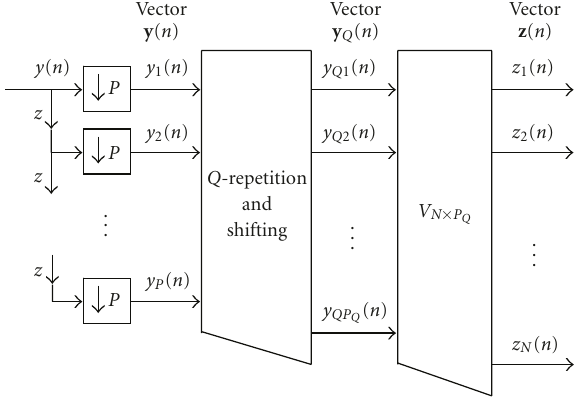
Figure 4: Receiver structure for frequency domain